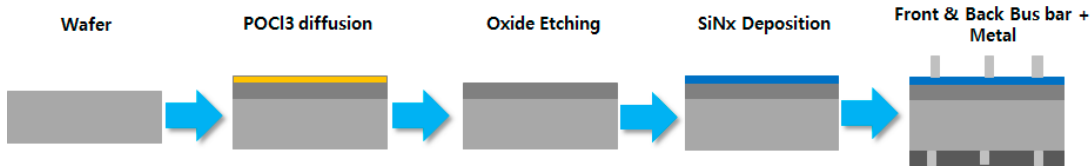
Figure 1. c-Si Solar cell manufacturing process.